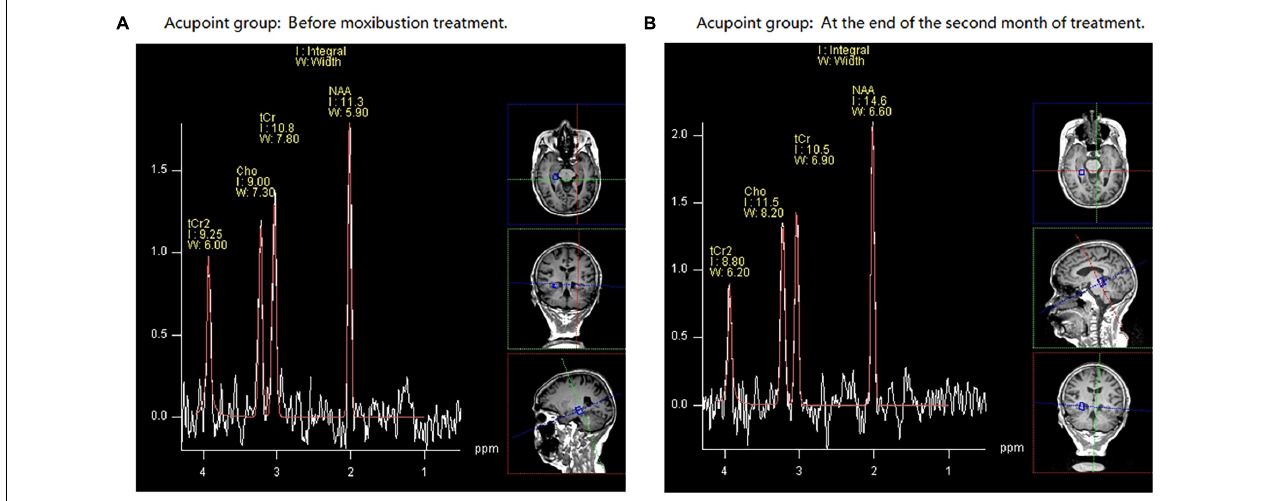
FIGURE 4 | An example of hydrogen proton magnetic resonance spectroscopy ( 1 H-MRS) data obtained in a 74-year-old female volunteer with mild cognitive impairment (MCI) from acupoint group. NAA, N -acetyl aspartate; Cho, choline; tCr, total creatine. Part (A) demonstrates that before moxibustion treatment, in the right hippocampus (HIP), the N -acetyl aspartate/total creatinine (NAA/tCr) ratio is 1.05 and choline/total creatinine (Cho/tCr) ratio is 0.84. Part (B) shows that at the end of the second month of treatment, in the right HIP, the NAA/tCr ratio is 1.40 and Cho/tCr ratio is